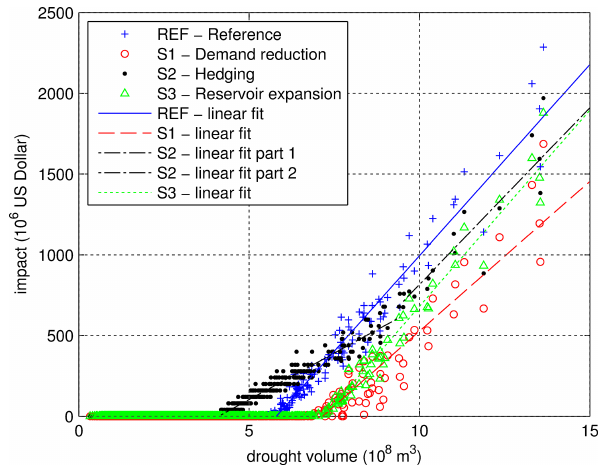
Figure 4. Response curves of the reference configuration (REF) and of the alternative configurations with implemented strategies (S1, S2 and